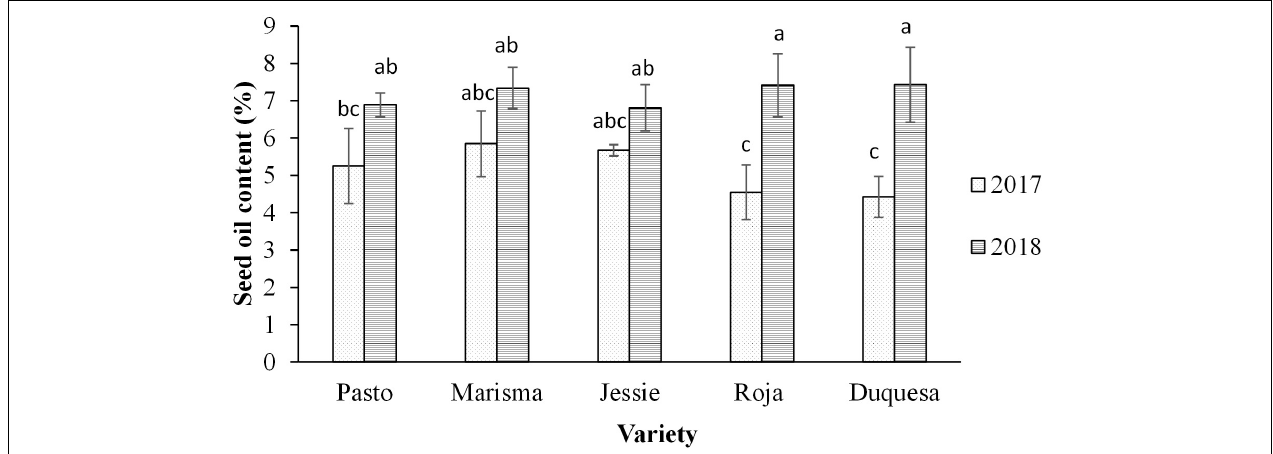
FIGURE 1 | Seed oil content of five quinoa varieties harvested in 2 years (2017 and 2018). Total seed oil content is expressed as percentage (%). Error bars correspond to the SDs. Bars that do not share the same letters show statistically significant differences following an ANOVA test and Tukey’s post hoc test at a p -value <